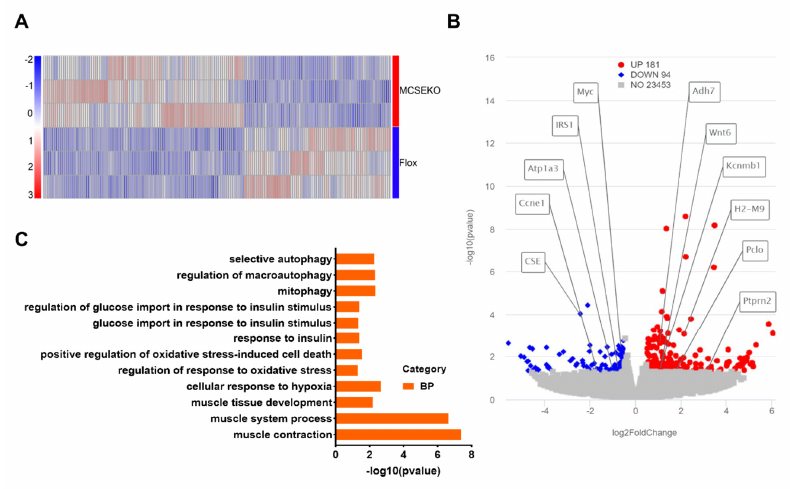
Figure 3. RNA-seq based transcriptome of skeletal muscle of MCSEKO mice. The mice were housed under standard conditions until 20-weeks-old, and then sacrificed under deep anesthesia. GAS was obtained for RNA-seq analysis. ( A ) Heat map of differentially expressed genes in the GAS of Flox mice and the MCSEKO mice ( n = 3 in each group). ( B ) Volcano plot of differentially expressed genes in GAS of Flox mice and the MCSEKO mice ( p < 0.05 and |log2FoldChange| > 0). The top eleven significantly different genes between the two groups were labeled. ( C ) The GO pathway enrichment analysis. Next, we performed the IGTT and ITT to examine glucose tolerance and insulin sen- sitivity. The MCSEKO mice showed normal IGTT and ITT relative to Flox mice at 10~11 weeks old (Figure 4A,E,I,M) and 15~16 weeks old (Figure 4B,F,G,N). Impaired glucose tolerance and insulin tolerance occurred at 20-weeks-old. As shown in Figure 4C, circula- tory glucose concentration was significantly increased 30, 60, 90, and 120 min after glucose administration in MCSEKO mice compared with Flox littermates. The area under the curve (AUC) of the blood glucose level was significantly higher in MCSEKO mice than that in Flox mice (Figure 4J). Moreover, ITT showed that significantly increased glucose levels occurred at 15, 30, 60, and, 90 min after insulin administration in MCSEKO mice compared with Flox littermates (Figure 4K). The AUC of blood glucose level was signifi- cantly higher in MCSEKO mice than that in Flox mice (Figure 4O). We then examined the effects of H 2 S donor GYY4137 treatment on glucose tolerance and insulin sensitivity in MCSEKO mice. With the six-week GYY4137 treatment, impaired glucose tolerance and reduced insulin sensitivity in MCSEKO mice were significantly re- versed (Figure 4D,H,L,P).